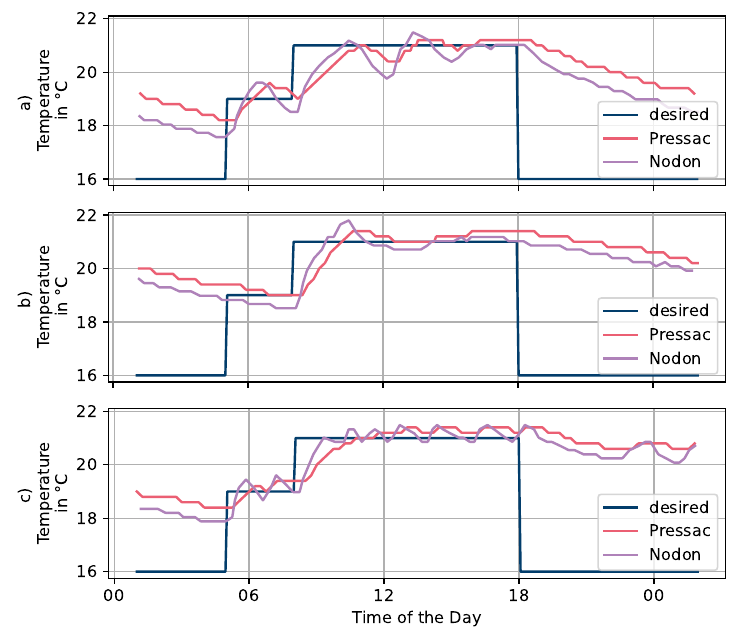
Figure 9. Comparison of temperature control with different measurements. ( a ) shows a control mode where no explicit temperature measurement is used but only a desired temperature is sent to the EnOcean valve actuator (Micropelt MVA005). The date of experiment was 4 February 2021. ( b ) shows a time span where a proportional controller in the cloud is used, with measurement input from the Pressac sensor and K P = 150. The data was sampled on 2 March 2021. ( c ) shows a time span where a control with K P = 150 is also used, but the measurements to feed the controller were those taken from the Nodon sensor. The experiment was conducted on 16 February